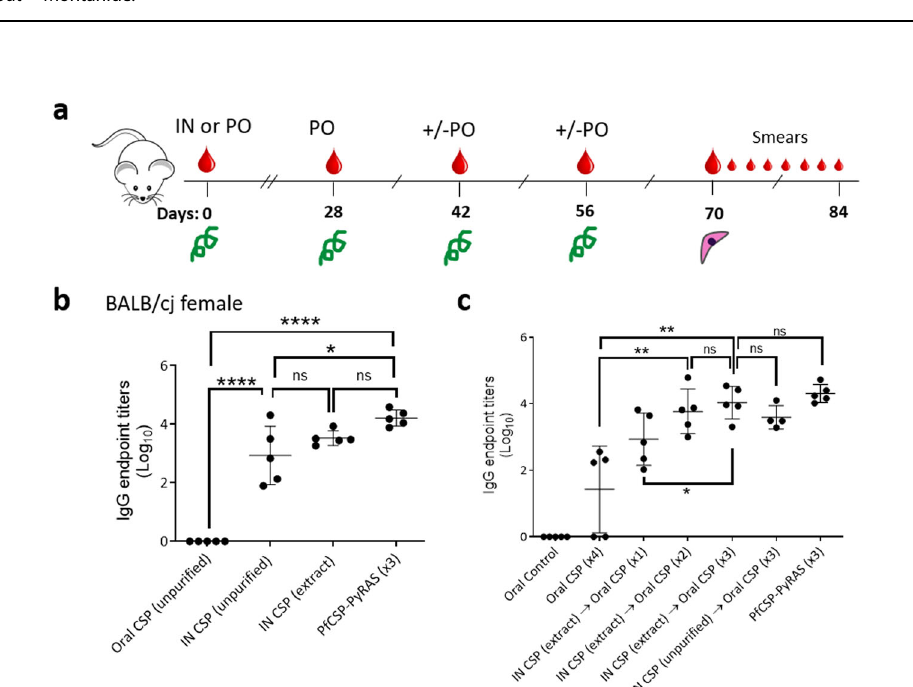
Fig. 2 Immunogenicity following intranasal priming and oral boosting. a Study design. On Day 0, BALB/cJ mice were primed via one of three ways: 1. Orally (PO) with unpuri fi ed spirulina biomass resuspended in HBSS; 2. Intranasally (IN) with unpuri fi ed spirulina biomass resuspended in PBS; or 3. Intranasally with spirulina total soluble protein extract. All doses were supplemented with Montanide adjuvant. Oral Montanide-adjuvanted spirulina booster doses (containing control or PfCSP unpuri fi ed biomass) were then given 1 – 3 times on Days 28, 42,